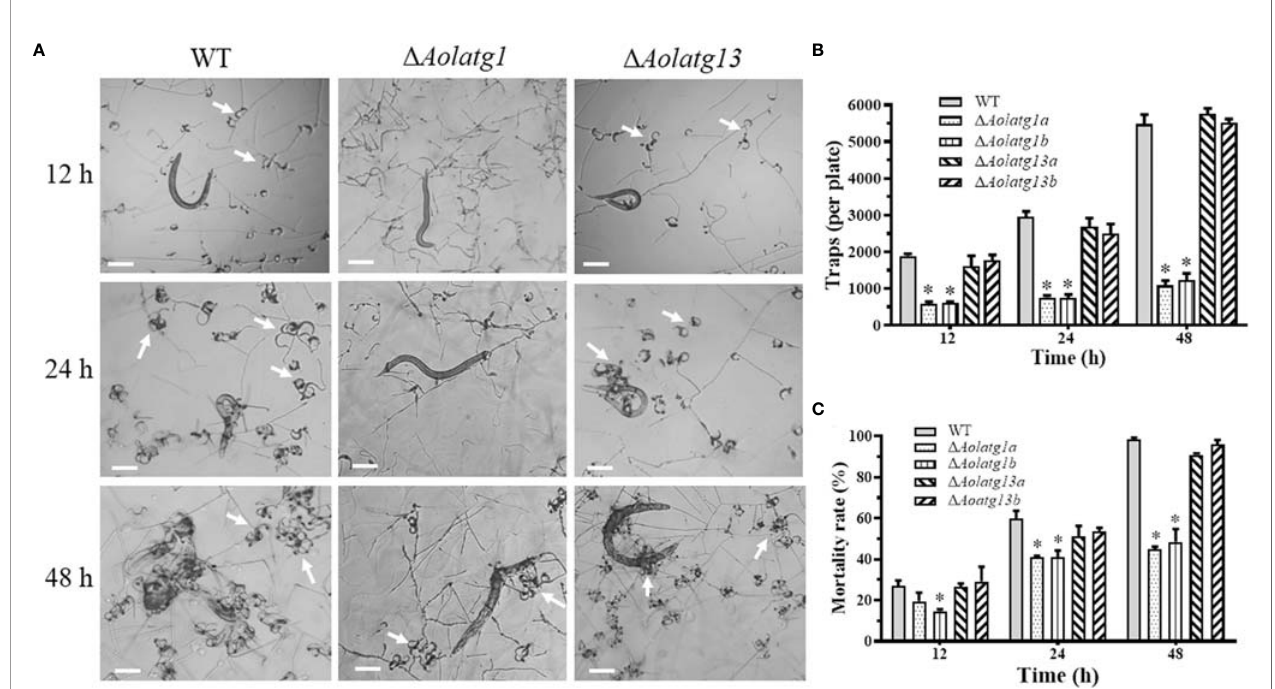
FIGURE 5 | Comparison of trap formation and nematicidal activity in the WT and mutant strains of A. oligospora . (A) Traps (indicated by white arrows) were induced by nematodes at 12, 24, and 48 h. Scale bars = 100 µm. (B) Traps produced by the WT and mutant strains at 12, 24, and 48 h. (C) Nematode mortality rate (%) at 12, 24, and 48 h. Data are presented as the mean ± standard deviation. Statistical signi fi cance of differences between mutant strains and WT strain is indicated as follows: * P < 0.05 (Tukey ’ s